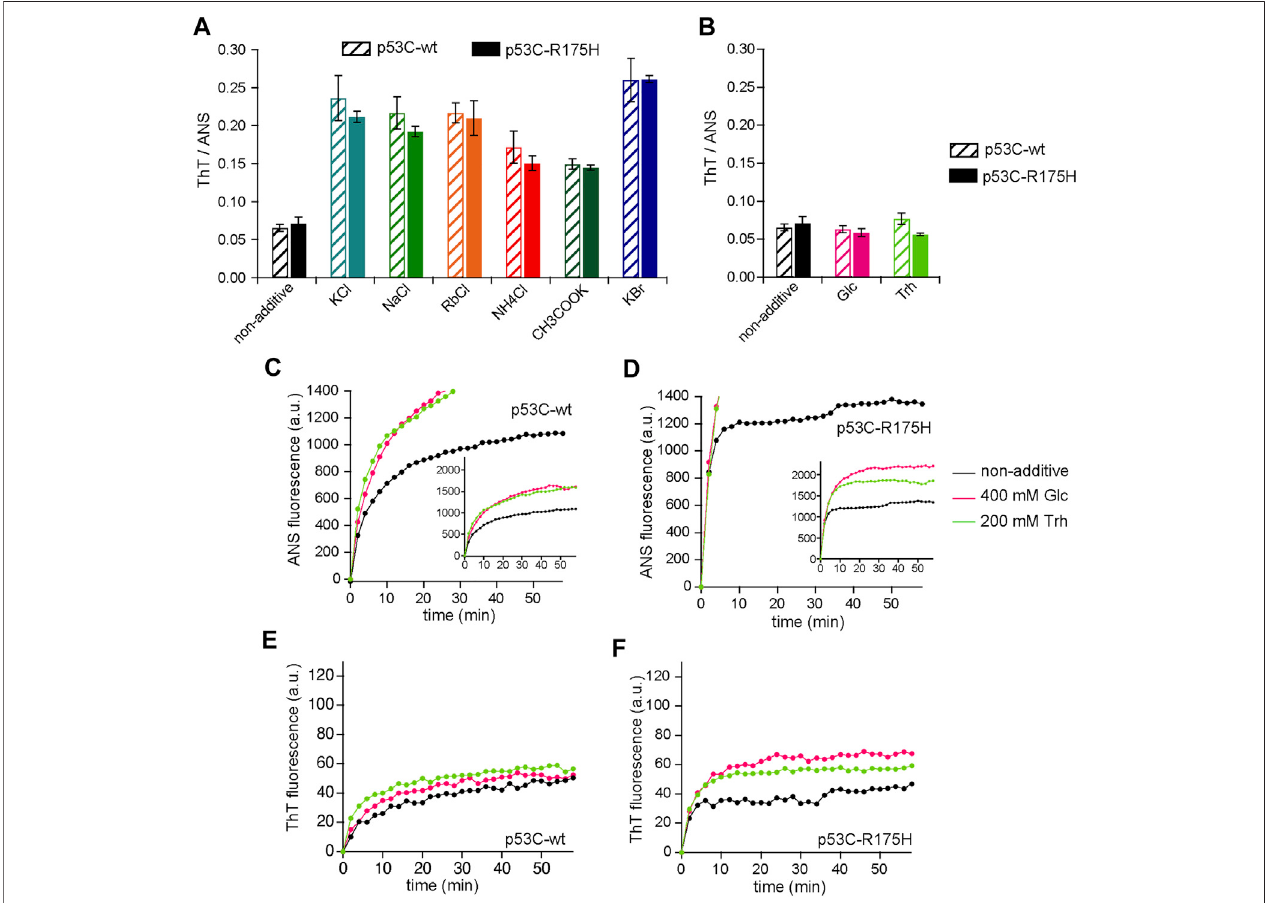
FIGURE 2 | (A,B) The ratio of ThT to ANS for various charged small additives (A) and uncharged additives (B) in p53-wt (shaded bars) and p53-R175H ( fi ll bars). (C – E) EffectofglucoseandTrhonaggregationofp53C-wtandp53C-R175H.Thedatafornon-additivesareidenticaltothosein Figures1A – D ,andhavebeenredrawn for comparison. p53C solution was aggregated at 37 ° C with 400 mM Glc (magenta) or with 200 mM Trh (light green), and the values were plotted every 2 min. (C) ANS fl uorescence in p53C-wt; (D) ANS fl uorescence inp53C-R175H; (E) ThT fl uorescence inp53C-wt; and (F) ThT fl uorescence inp53C-R175H.The insetof (C,D) is a graph with the vertical axis adjusted to include all the